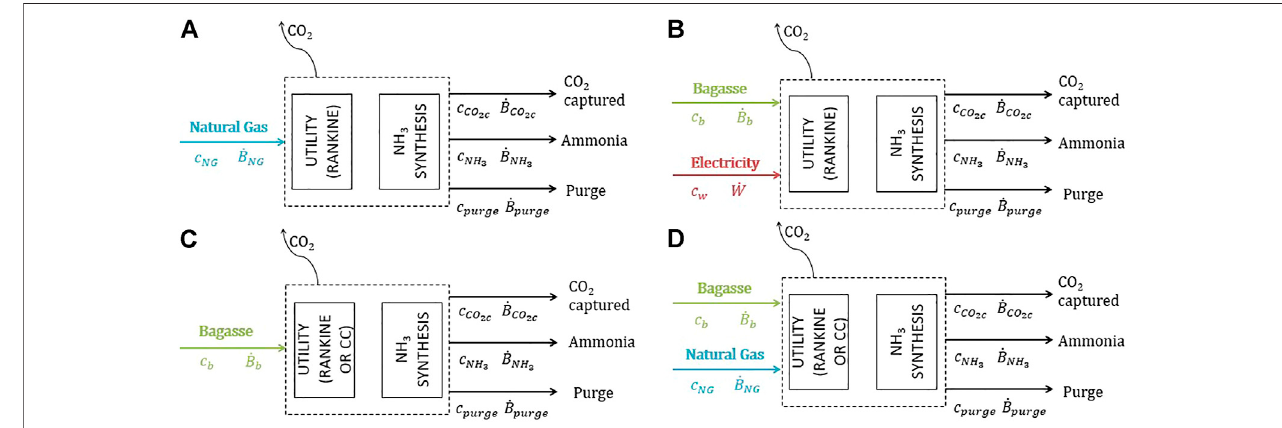
FIGURE 5 | Different scenarios of ammonia chemical plants and their utility systems depending on the feedstock and fuel energy resources used: (A) natural gas only; (B) bagasse and electricity; (C) bagasse only; (D) bagasse and natural gas.